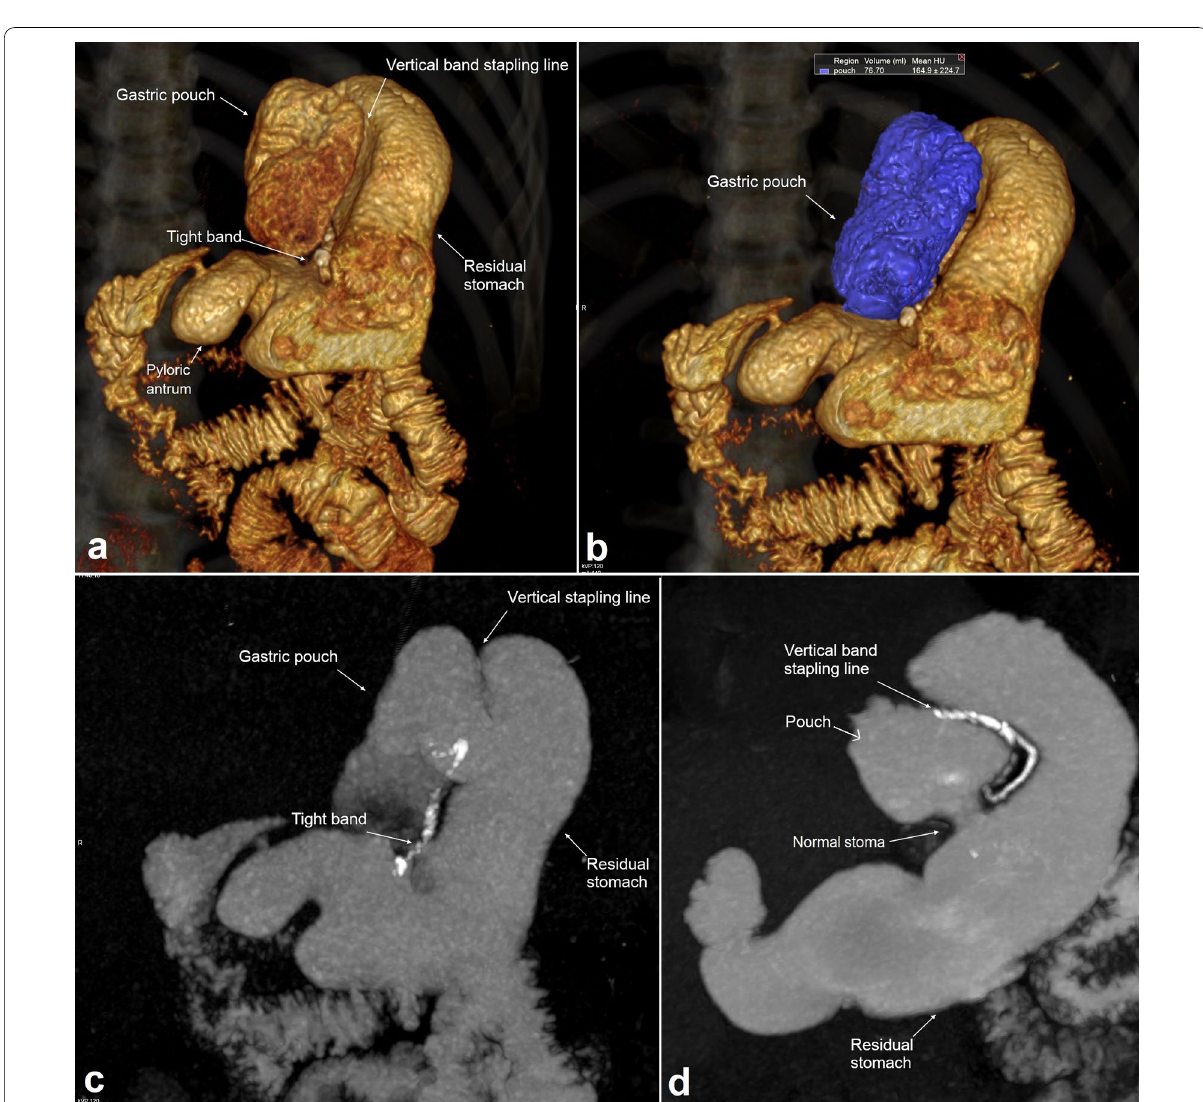
Fig. 4 Vertical banded gastroplasty complicated with pouch dilatation and stenosis of the connecting stoma. 3D volume rendered image ( a ) demonstrates the anatomical changes including intact vertical stapling line with pouch dilatation and tight band around stoma exerting stenosis. Pouch dilatation is evident in gastric volumetry image ( b ) coded with blue color, its volume radiodense vertical stapling line, narrowed stoma with filling defects within the dilated pouch mostly representing retained food particles. Normal appearing gastric stoma from another with the same procedure is demonstrated in ( d ) for